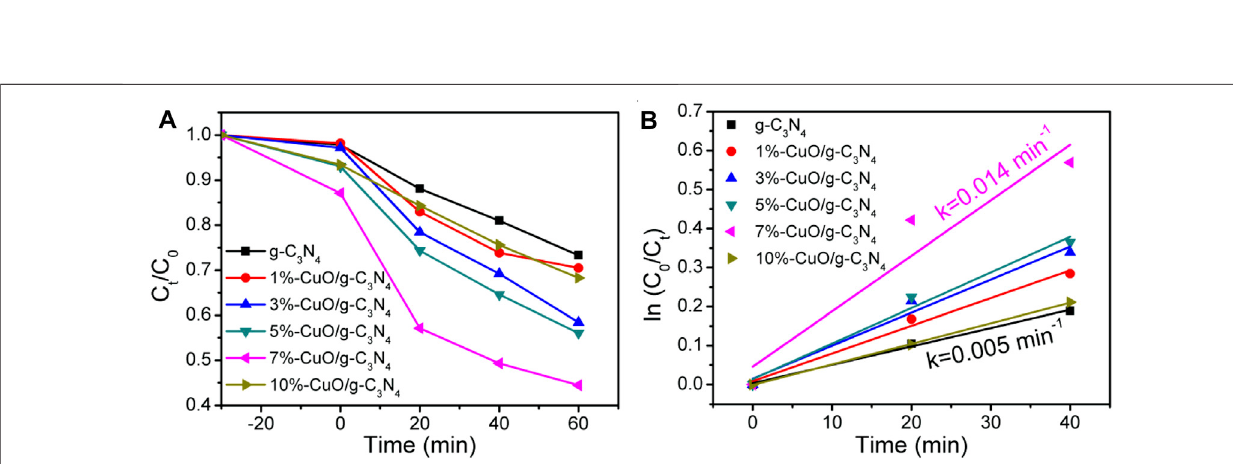
Frontiers in Chemistry |